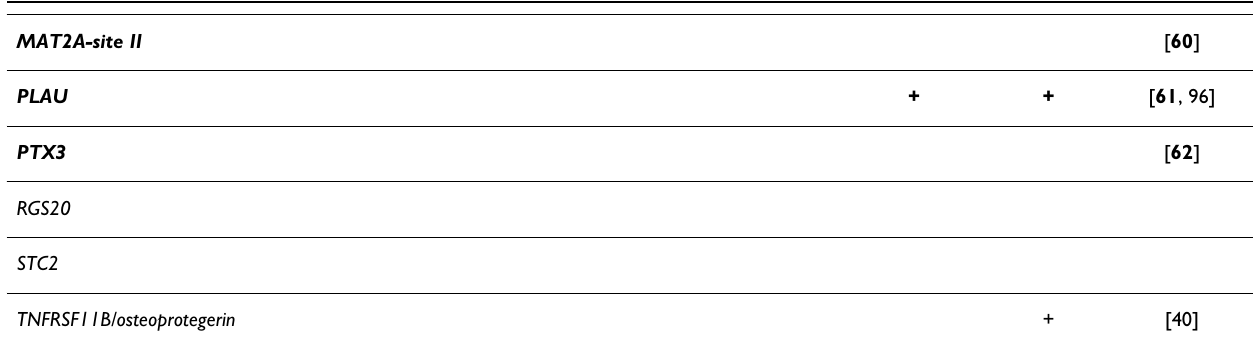
Table 7: FOXO and NF  B regulated genes.